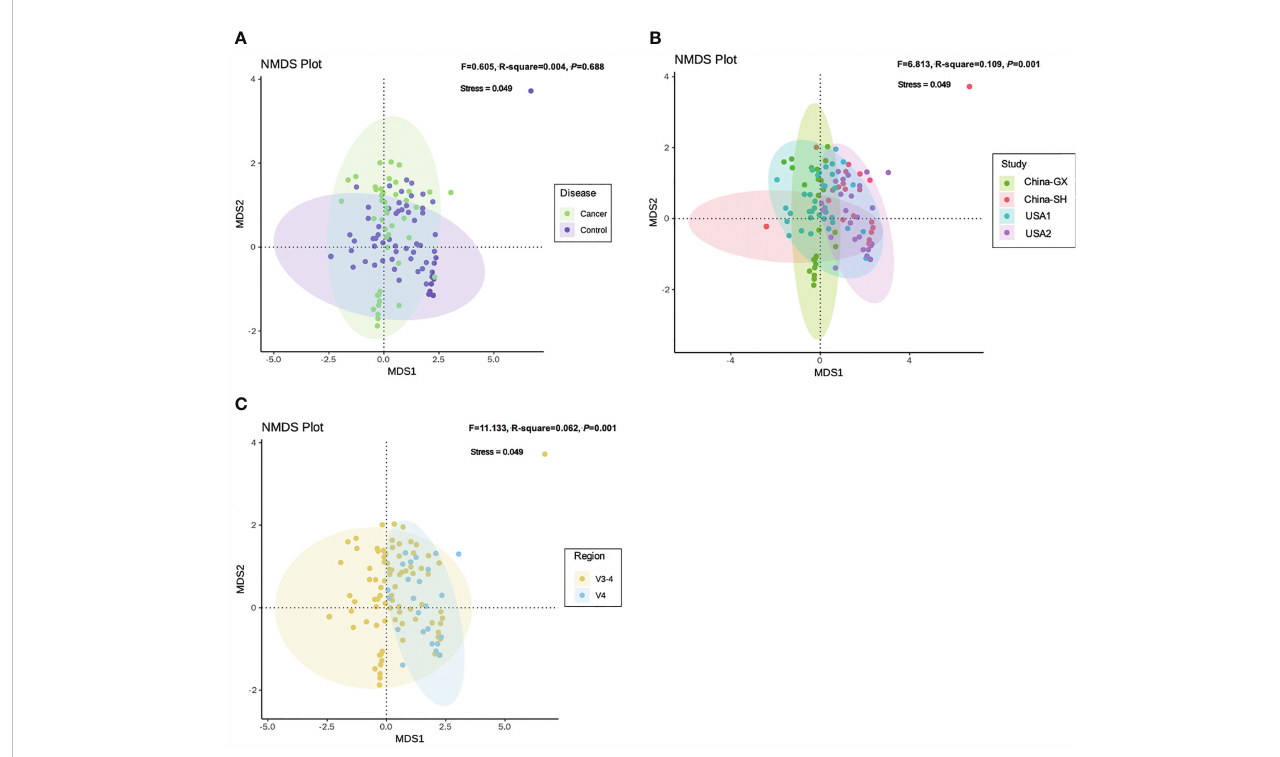
FIGURE 4 Non-metric multidimensional scaling analysis for all 16S rRNA samples based on genus-level according to the variables relevant to the disease (A) , study (B) and hypervariable region (C) . Adonis test indicated the explained variances with respect to cervical cancer and other variables.